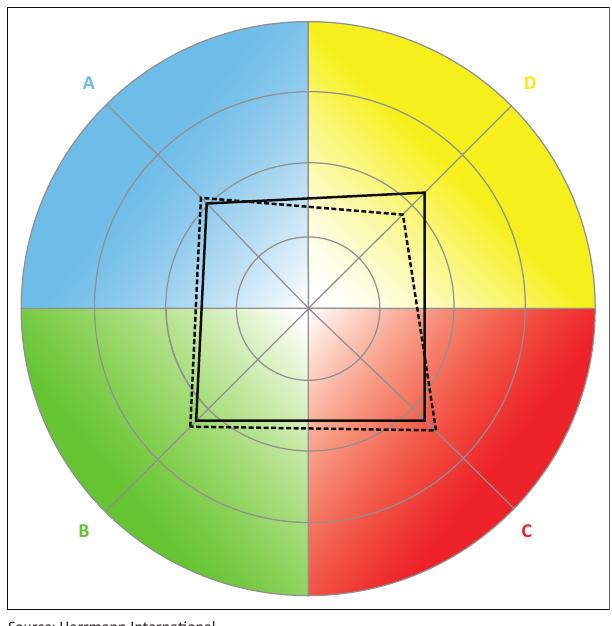
FIGURE 4: Average profile of a group of Postgraduate Certificate in Higher Education (PGCHE)